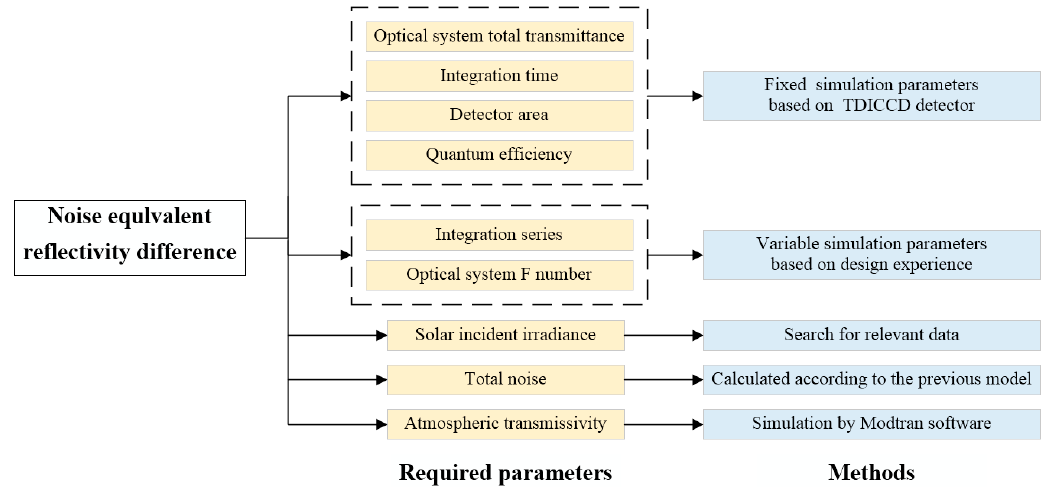
Figure 5. Calculation process of noise equivalent reflectivity difference.